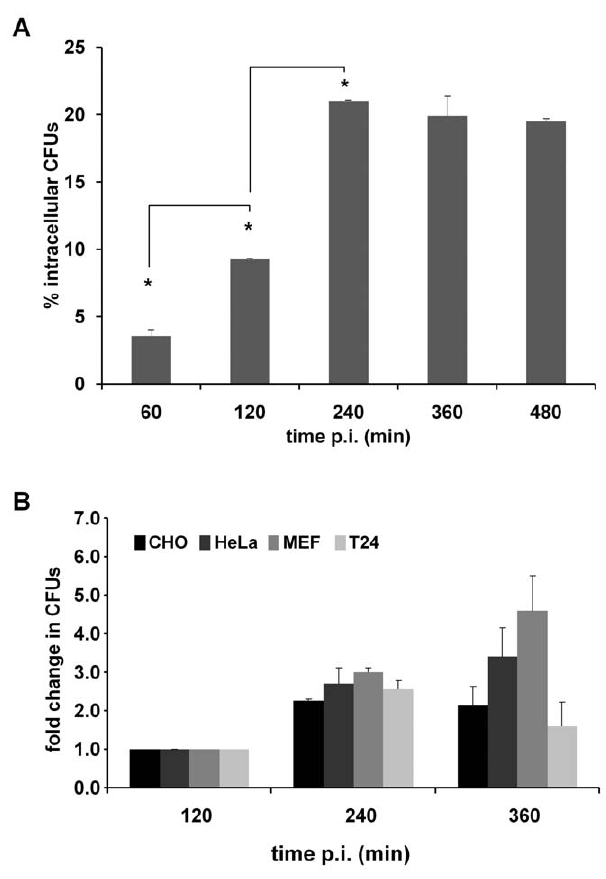
Figure 1. S. marcescens invades and replicates inside non- phagocytic cells. A) CHO cells or B) CHO, HeLa, MEF Atg5 + / + and T24 cells were infected for 60 min with wild-type S. marcescens and then extracellular bacteria were eliminated with gentamicin. At the indicated times, cells were washed with PBS and lysed with 0.05% Triton X-100. The CFUs were determined on LB agar plates, percentages were calculated relative to CFUs in the inoculum. In the plot shown in (B) fold change in CFUs were calculated relative to the values obtained at 120 min p.i. The average 6 S.D. for two independent experiments is shown (* p ,